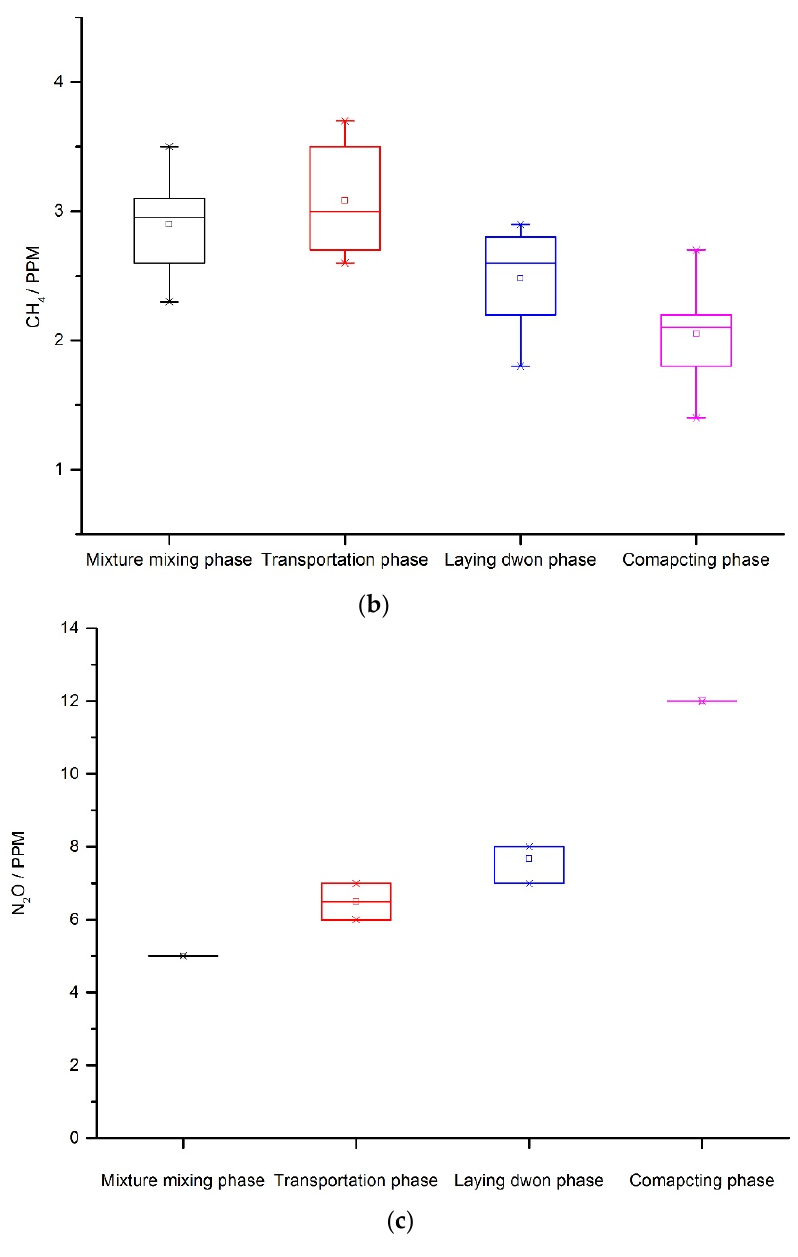
Figure 5. ( a ) CO 2 concentration from onsite construction process. ( b ) CH 4 concentration from onsite construction process. ( c ) N 2 O concentration from onsite construction process